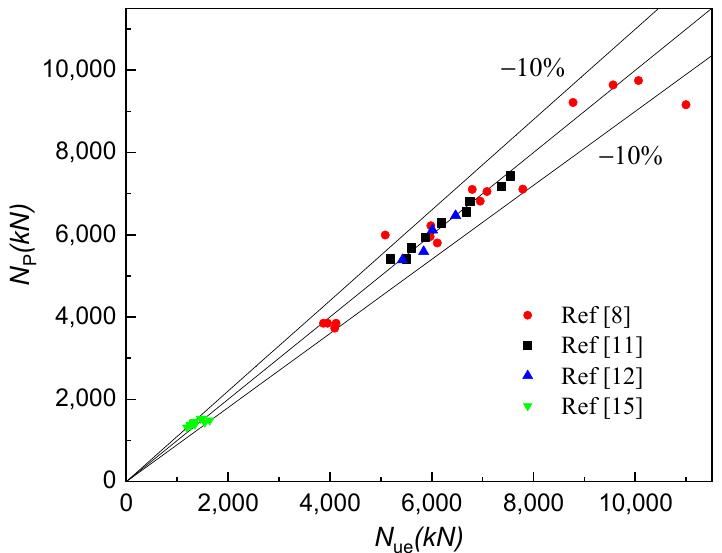
Figure 21. Comparison of test and prediction in ultimate strength.